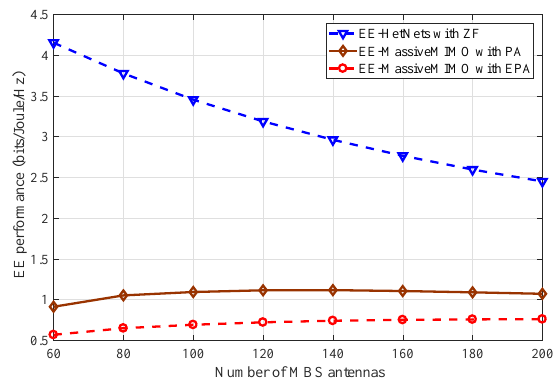
Figure 3. The EE performance versus the total number of antennas in a HetNet scenario. Energy efficiency zero-forcing for HetNets and massive MIMO beamforming are employed. The throughput threshold per user is 4